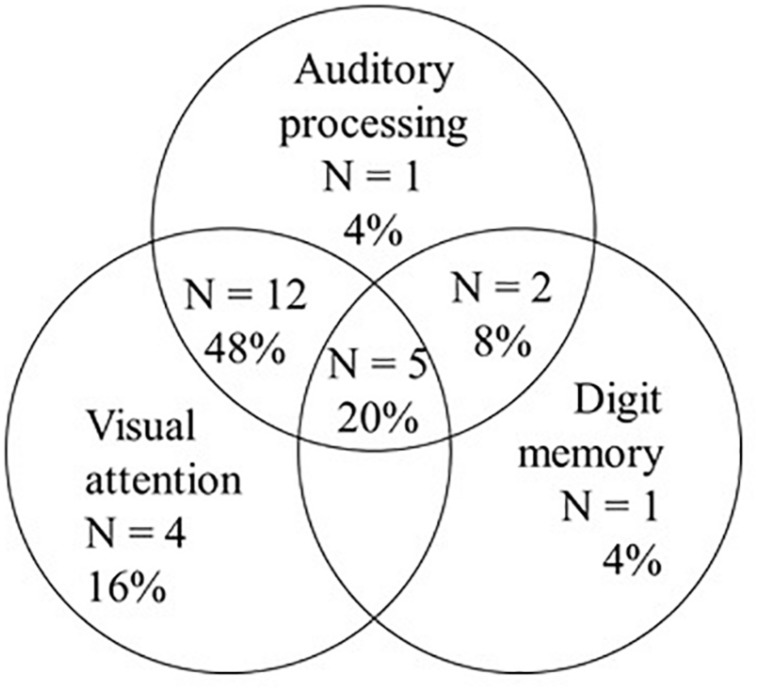
Venn diagram displaying the co-morbidities observed in the children (n = 25) with word reading difficulties in the current study.